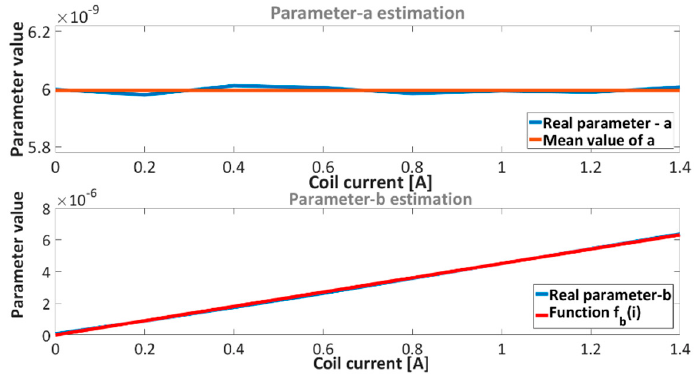
Figure 10. Estimated parameters ( top ) a and ( bottom ) b .